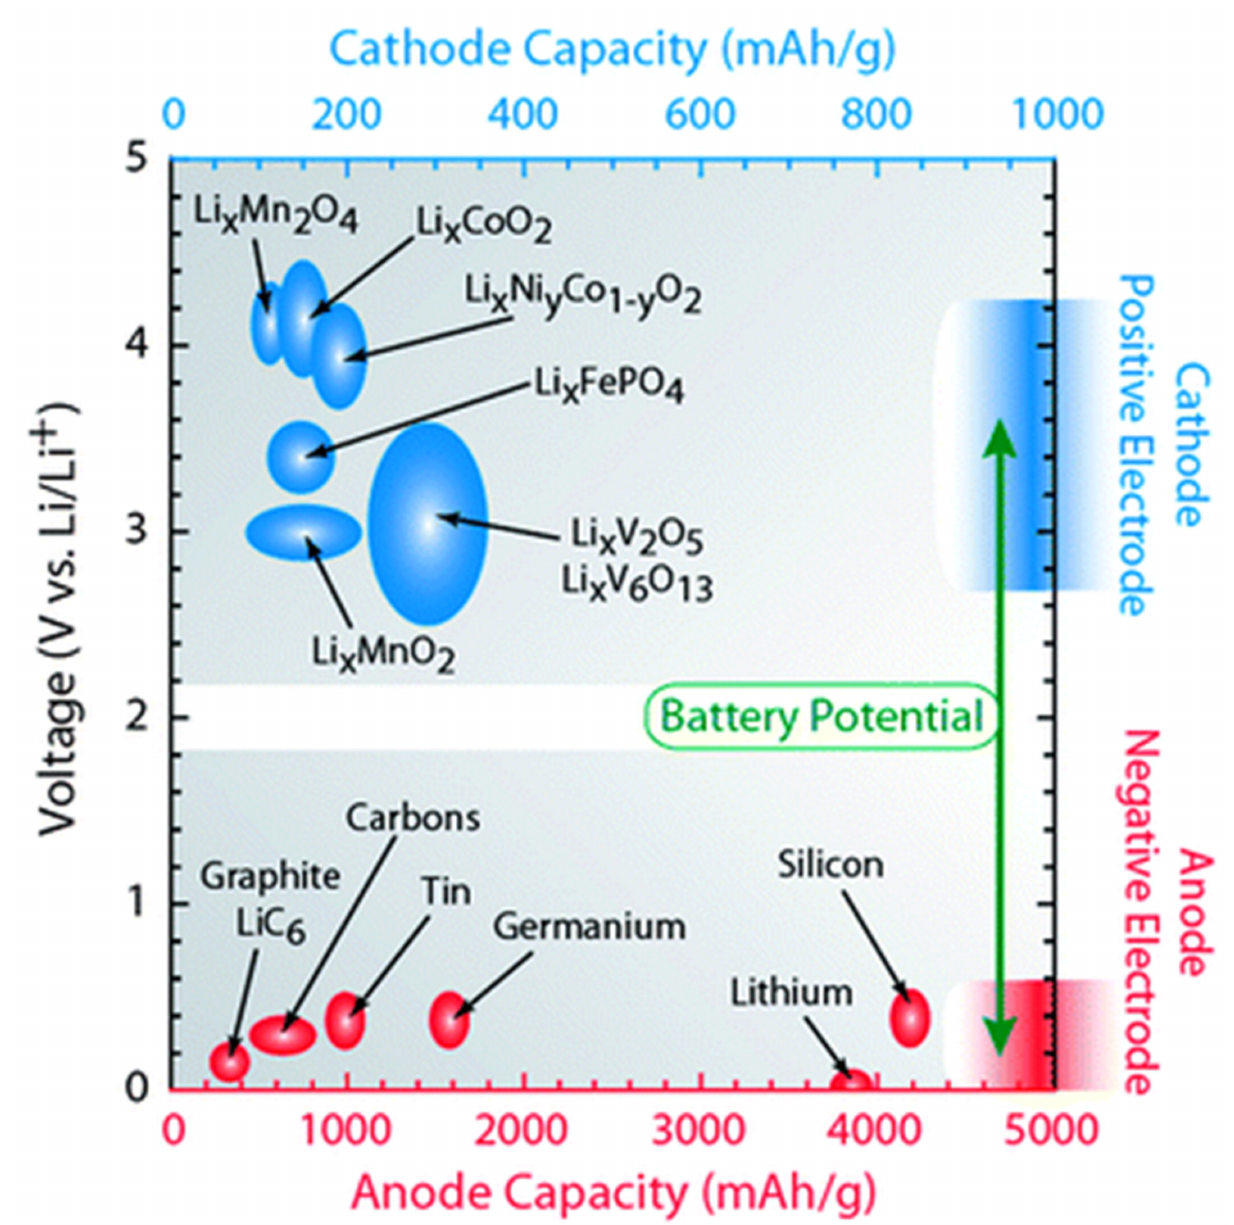
Figure 7. Specific capacities of common cathodes and anode materials in LIBs (adapted with permission from [158]. Energy Environ. Sci.,